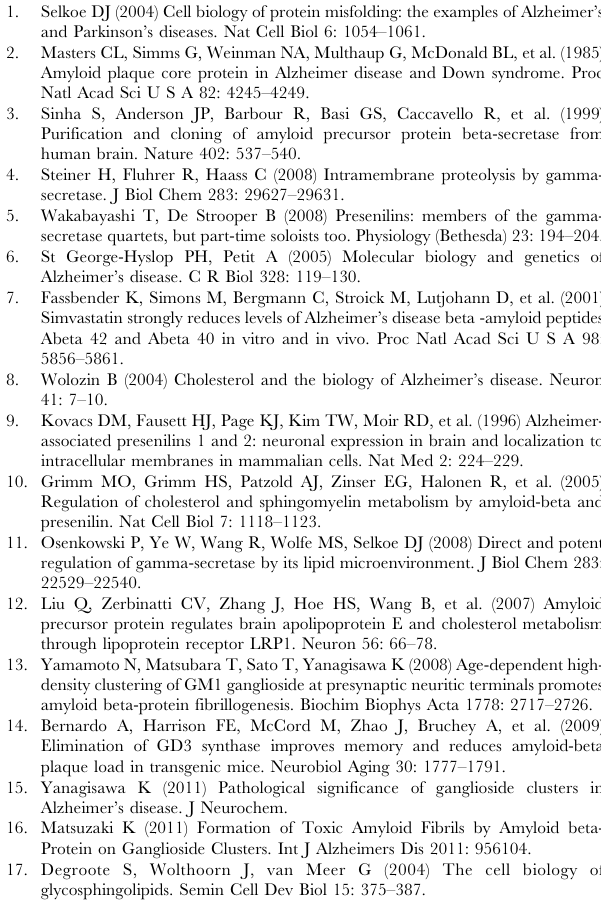
Figure S11 Determination of GD3S assay unspecificity. As negative control for the GD3S assay we used ganglioside GM2. Compared to the positive control using ganglioside GM3, GM2 was unable to stimulate GD3S. Only a background signal is obtained. Table S1 Rowdata obtained from quantitative Real-Time PCR experiments. Tables display all D Ct values, DD Ct values and 2 2 ( DD Ct) normalized to mRNA actin levels as described in Livak and Schmittgen [72]. At least three independent RNA prepara- tions of at least three different brains or cell culture dishes were analyzed. Figure numbers refer to the original figures in the